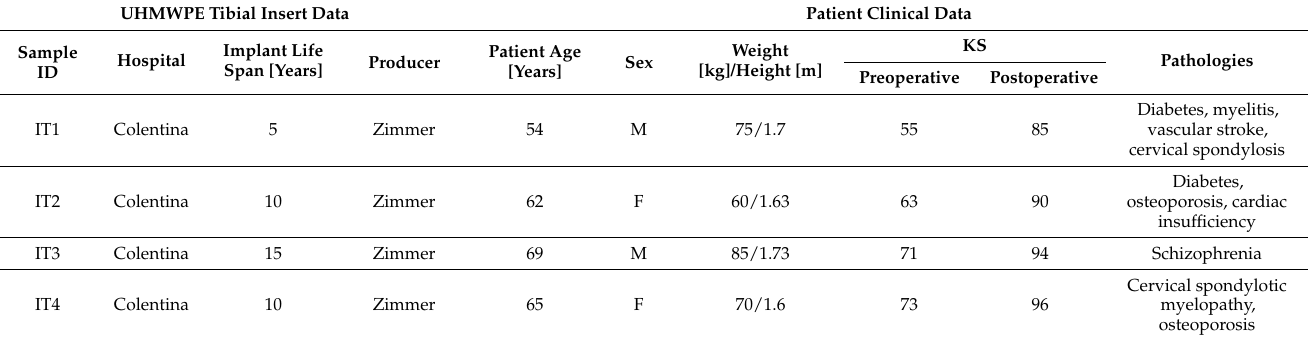
Table 1. Experimental samples and statistics data on patients with knee implant